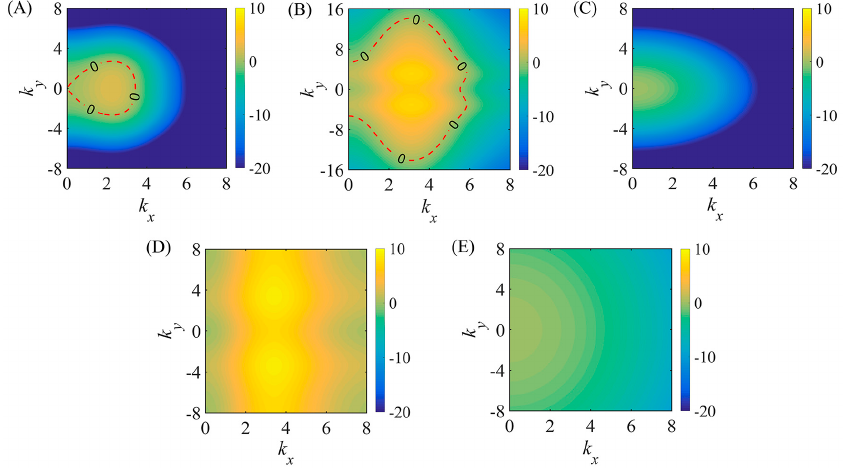
Figure 2. The growth rate as function of the topographic wave numbers (cid:1863) (cid:3051) and (cid:1863) (cid:3052) for (cid:1866) = 1 , (cid:2010) (cid:2869) = 10° , (cid:2010) (cid:2870) = 12° , (cid:2020) (cid:3036) ((cid:1861) = (cid:1876), (cid:1877)) = 0.4 , (cid:1830) = 0.5 , and (cid:2035) = 0.25 . The total growth rate ( A ) is the sum of the growth rates due to reptation ( B ) and creep ( C ). The reptation growth rate is the sum of two contributions: ( D ) the impact-induced reptation flow and ( E ) the impact-induced gravity flow.